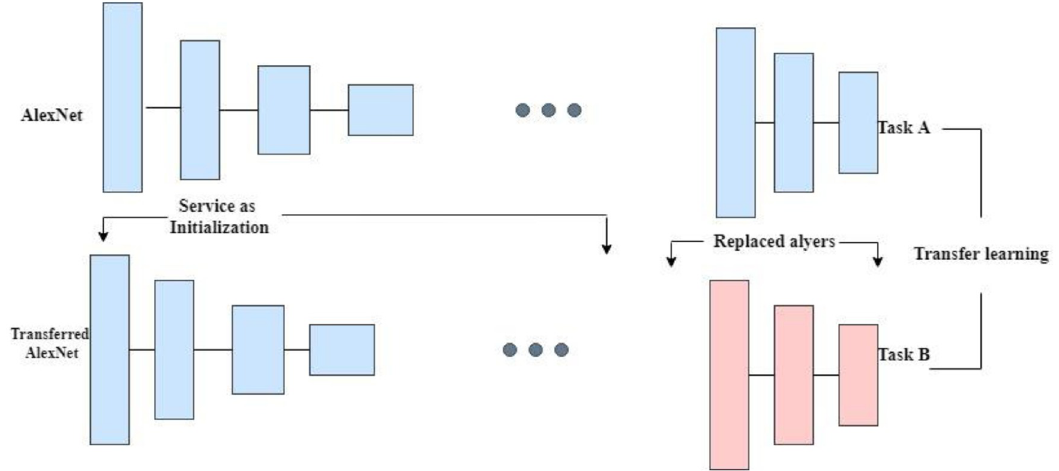
Fig 7. The transfer learning process of